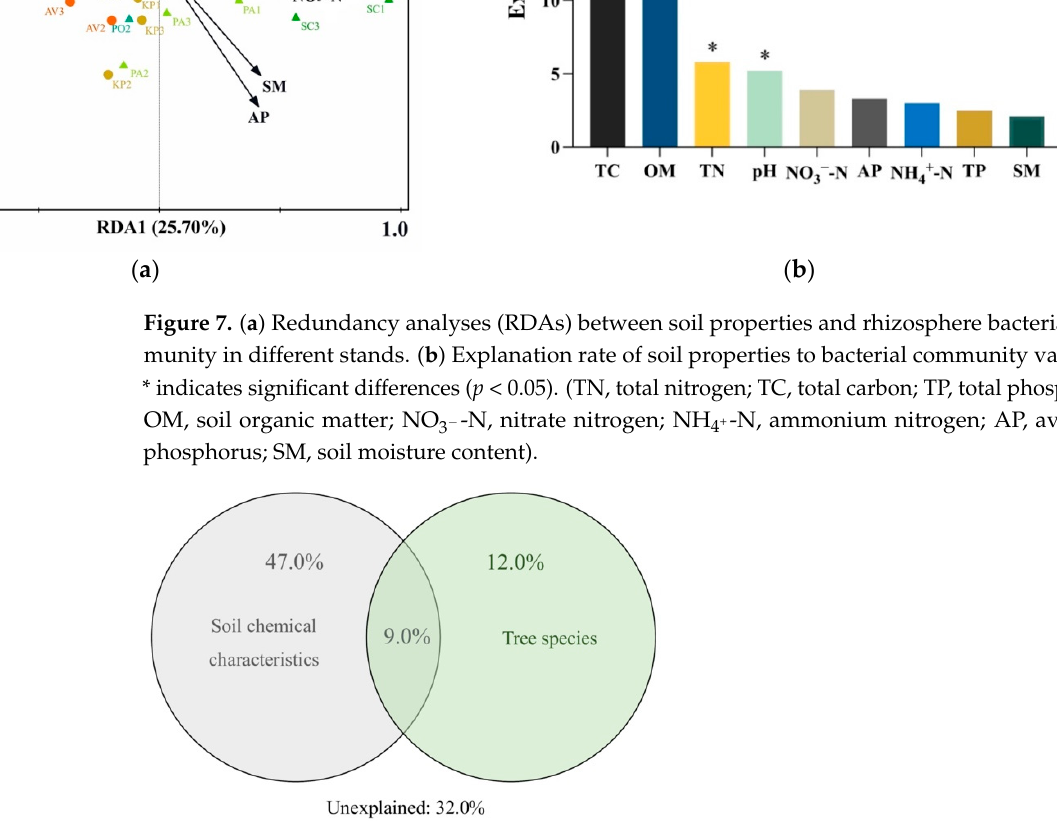
Figure 8. Variation partitioning analysis (VPA) between environmental variables and rhizosphere bacterial genera.